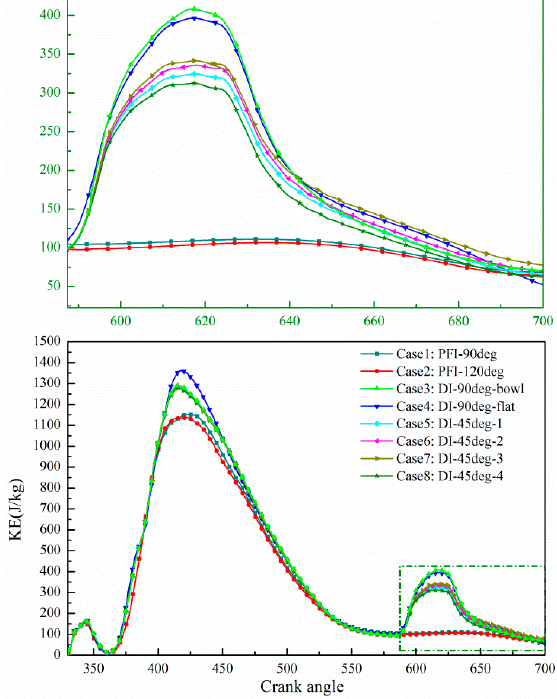
Figure 5. Kinetic energy and enlarged diagram of Cases 1–8.